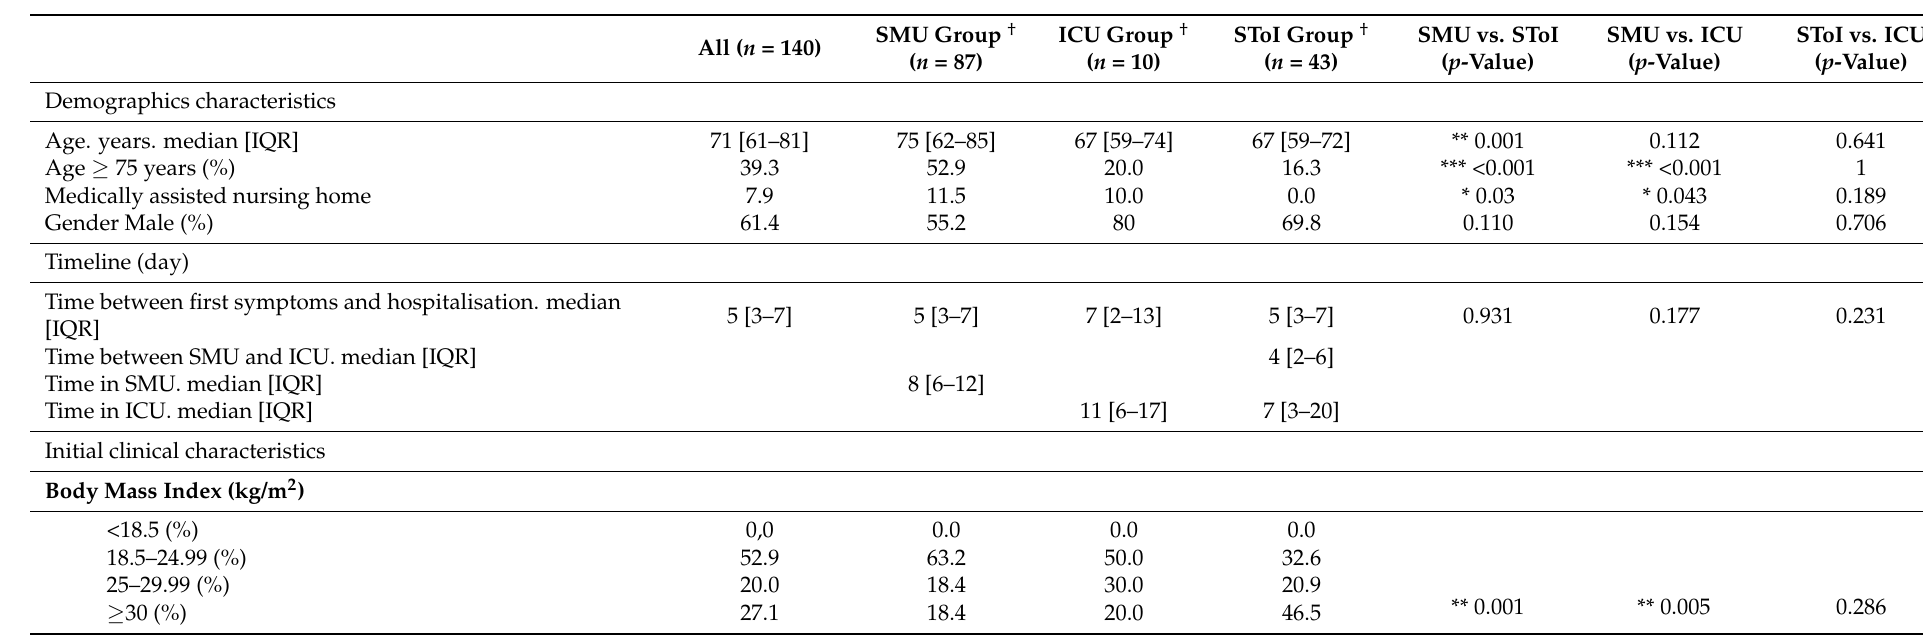
Table 3. Population’s characteristics (demographics data, important timelines, initial vital sign, income data, comorbidities, outcome data); comparison between groups for validation cohort. Parameters with a p -value < 0.05 have significative differences between groups compared. * p < 0.05; ** p < 0.01; *** p <